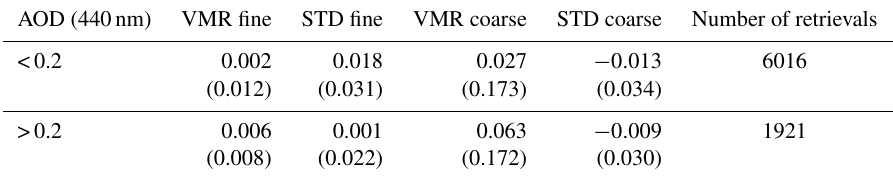
Table 6. Statistics, average values and standard deviations (in parentheses) of the difference in volume median radius (VMR) and width of particle size distribution (STD) retrievals of V2 and V3 for the GSFC site. The difference is defined as V3 − V2. AOD